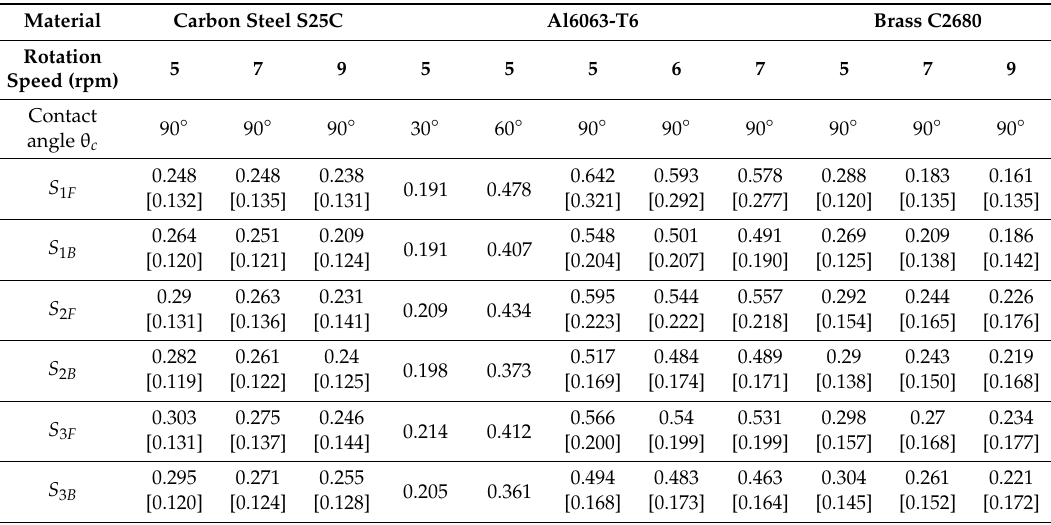
Table 3. Average friction coe ffi cients µ under dry friction, values in square brackets denote µ under lubricated